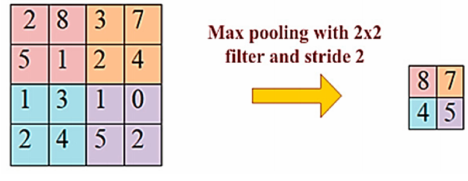
Fig. 3 Visualization of max-pooling layer